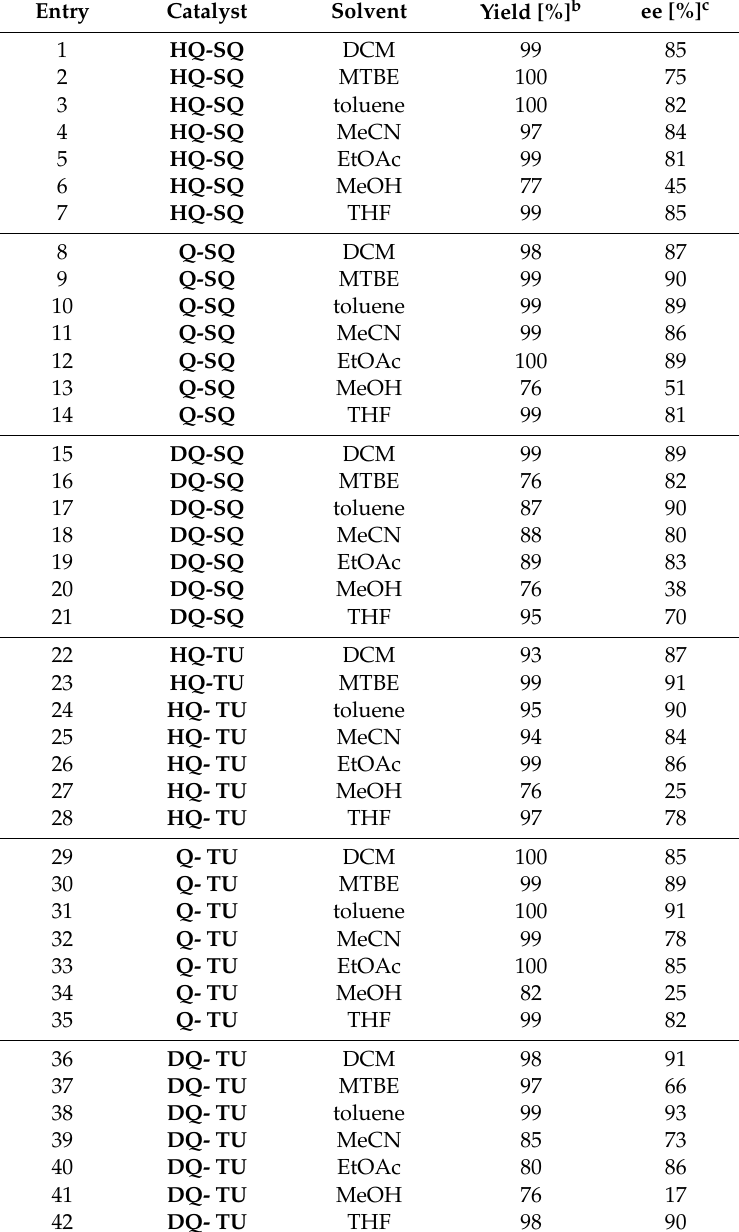
Table 3. Catalysts applied in Michael addition using trans - β -nitrostyrene ( 1 ) and pentane-2,4-dione ( 2 ) a